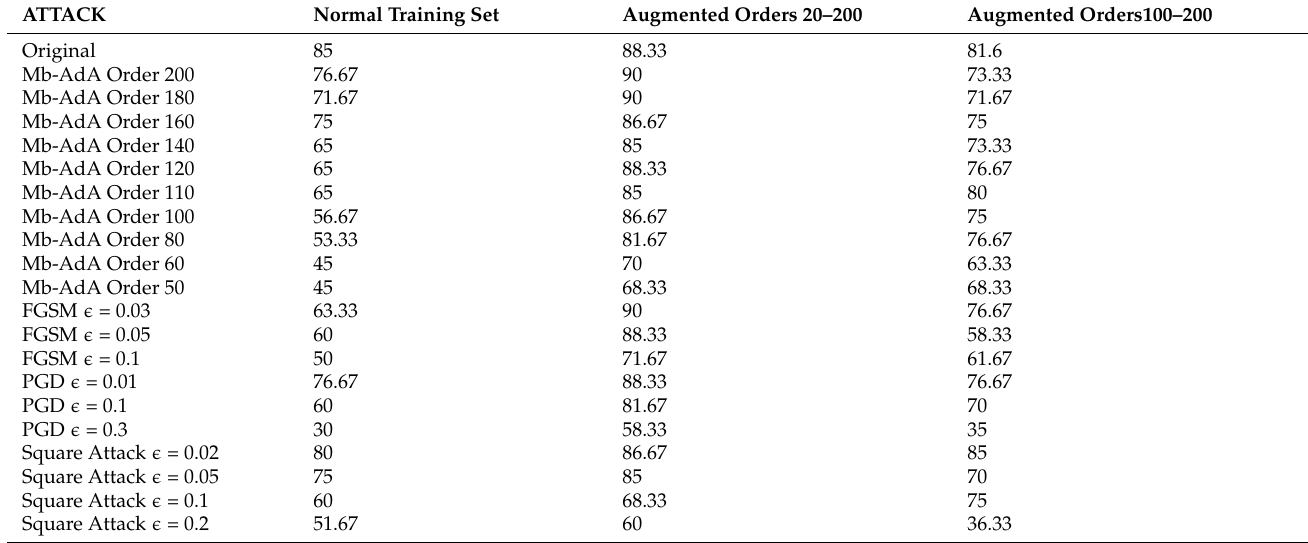
Table 4. Accuracy after adversarial training in histopathological images with MobileNetV2 (in